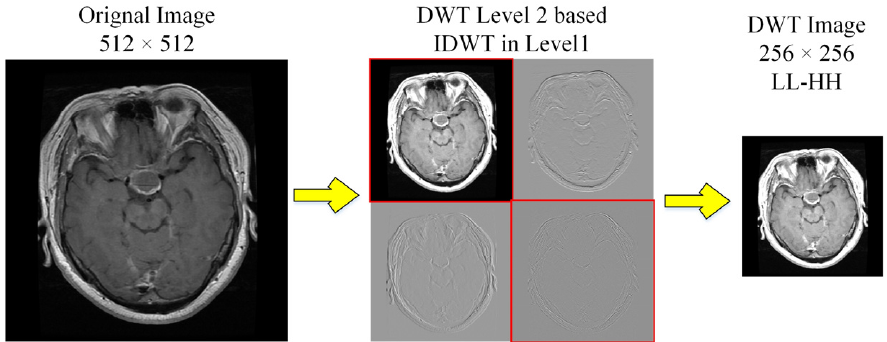
Figure 4. DWT decomposition of MRI scans to obtain high contrast images.